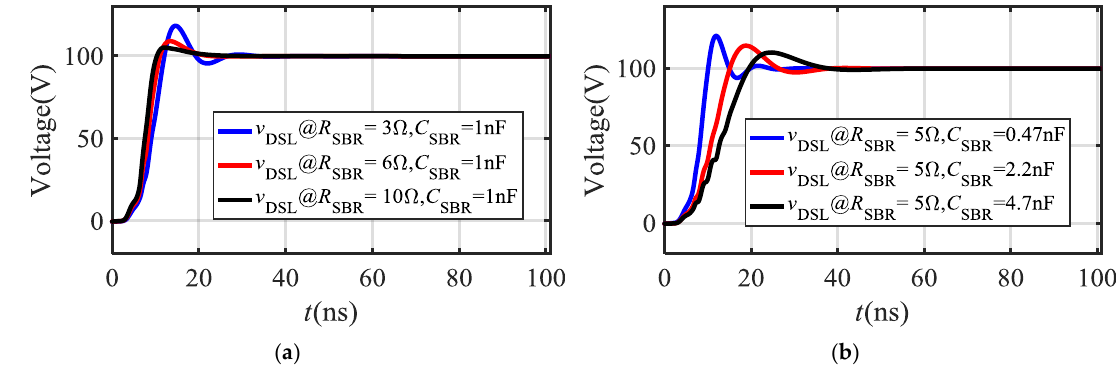
Figure 11. Simulation results of voltage ringing for different snubber cases ( a ) C SBR = 1 nF and R SBR = 3, 6 and 10 Ω ( b ) R SBR = 1 Ω and C SBR = 0.47, 2.2 and 4.7 nF.